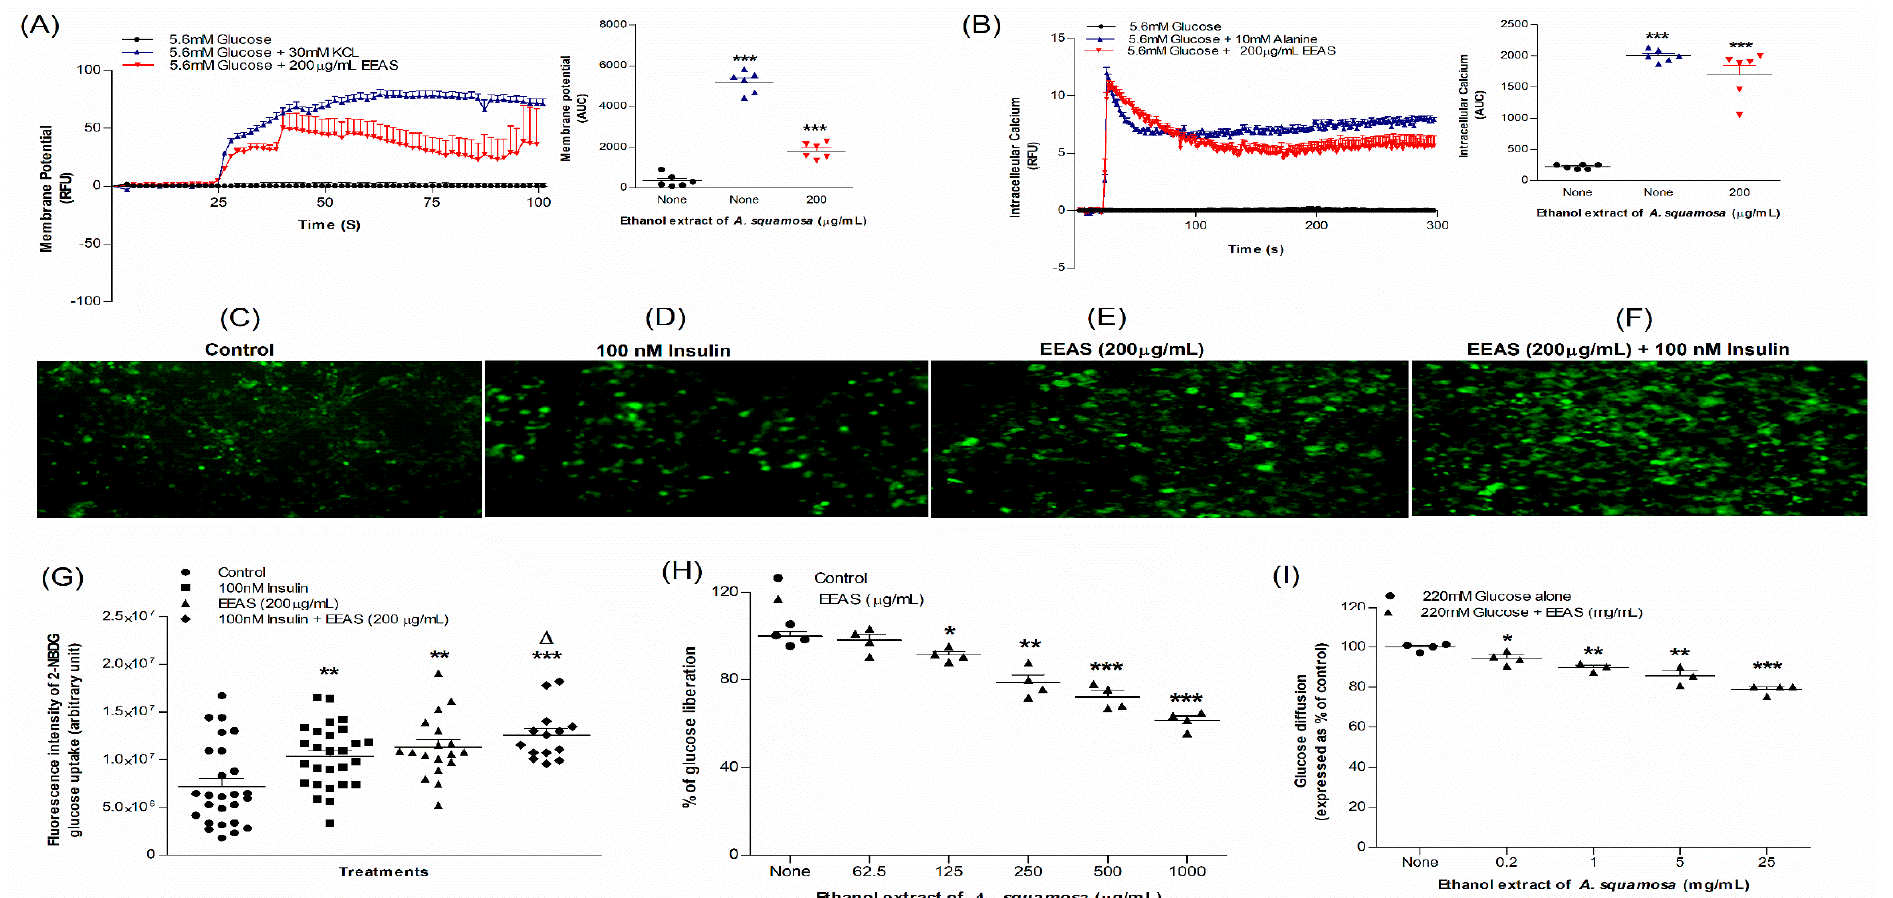
Figure 2. Effects of EEAS on ( A ) membrane potential and ( B ) intracellular calcium in clonal pancreatic β cells (BRIN BD11), and ( C – G ) glucose uptake, ( H ) starch digestion, and ( I ) glucose diffusion in vitro. Changes of fluorescence intensity in differentiated 3T3L1 adipocytes incubated with EEAS ( E ) without or ( F ) with 100 nM insulin. Values n = 6 for membrane potential and intracellular calcium, n = 4 for uptake of glucose, digestion of starch, and diffusion of glucose are mean ± SEM.*, **, *** p < 0.05–0.001 compared to control. Δ p < 0.05 compared to 100 nM insulin alone.